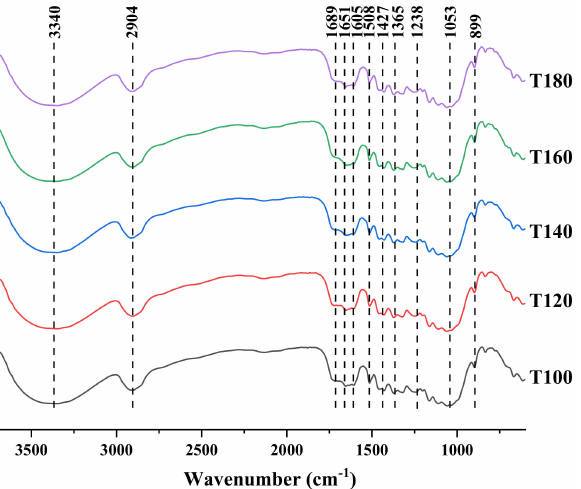
Figure 5. Infrared spectra of corn stalk treated with different ultrasound